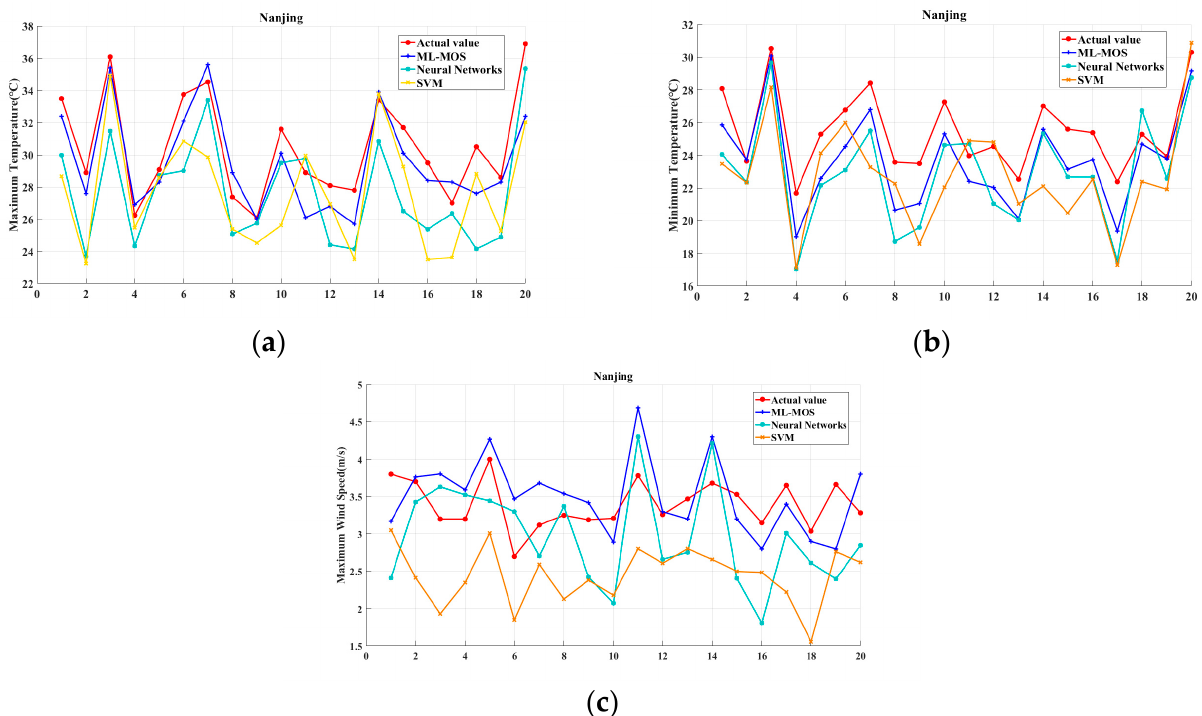
Figure 10. Comparison of the prediction results of ( a ) T max , ( b ) T min and ( c ) W max with different